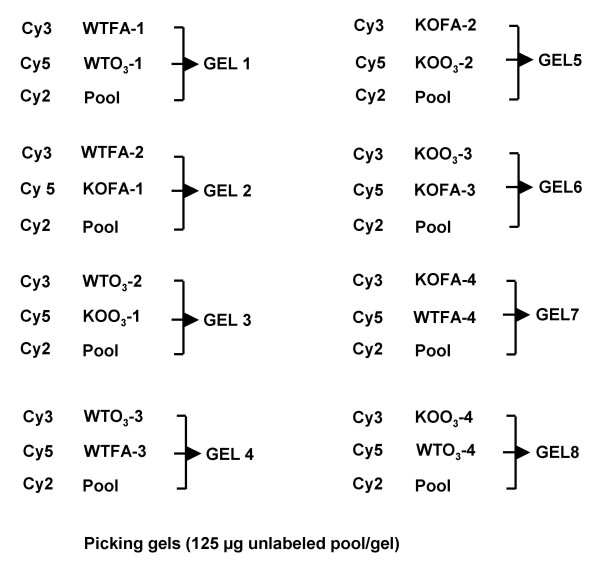
Sample layout for 2D-DIGE. The arrangement of individual samples for staining with either Cy3 or Cy5 and their layout on the gels is presented diagrammatically. Note that for each group of 4 samples two were stained with Cy3 and two with Cy5. An aliquot of a Cy2-labeled pool is included on all gels.